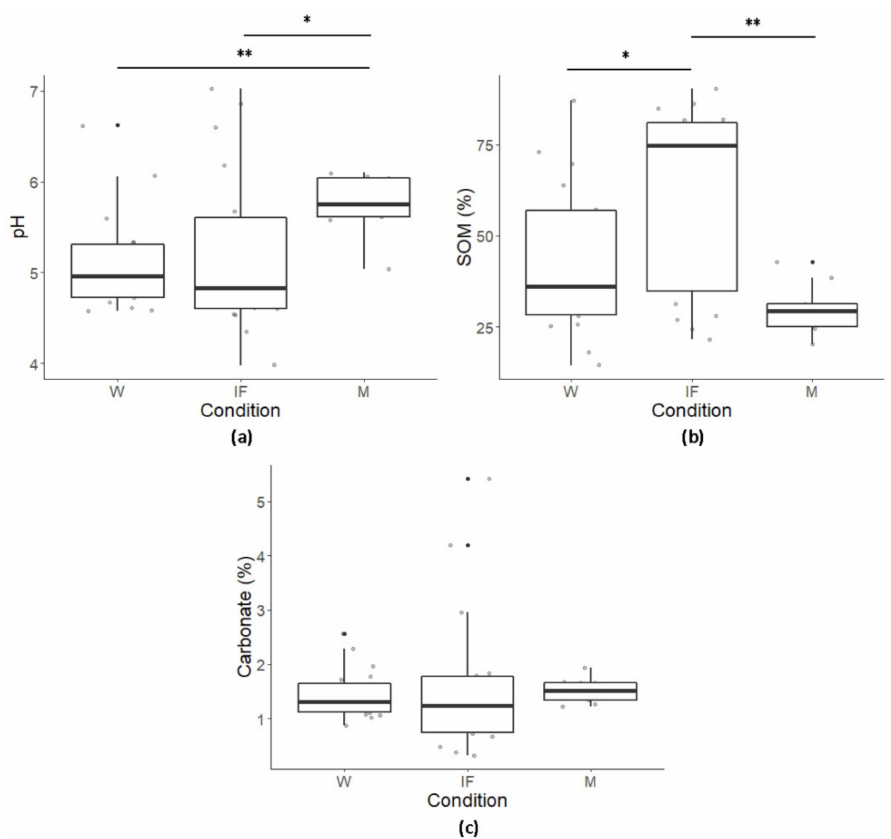
Figure 2. Boxplots of ( a ) pH, ( b ) SOM (%), and ( c ) carbonate (%) under each condition. The bottom and top of each box represent the lower and upper quartiles, respectively; the line inside each box shows the median, and whiskers indicate minimal and maximum observations. Asterisks mean: * p ≤ 0.05, ** p ≤